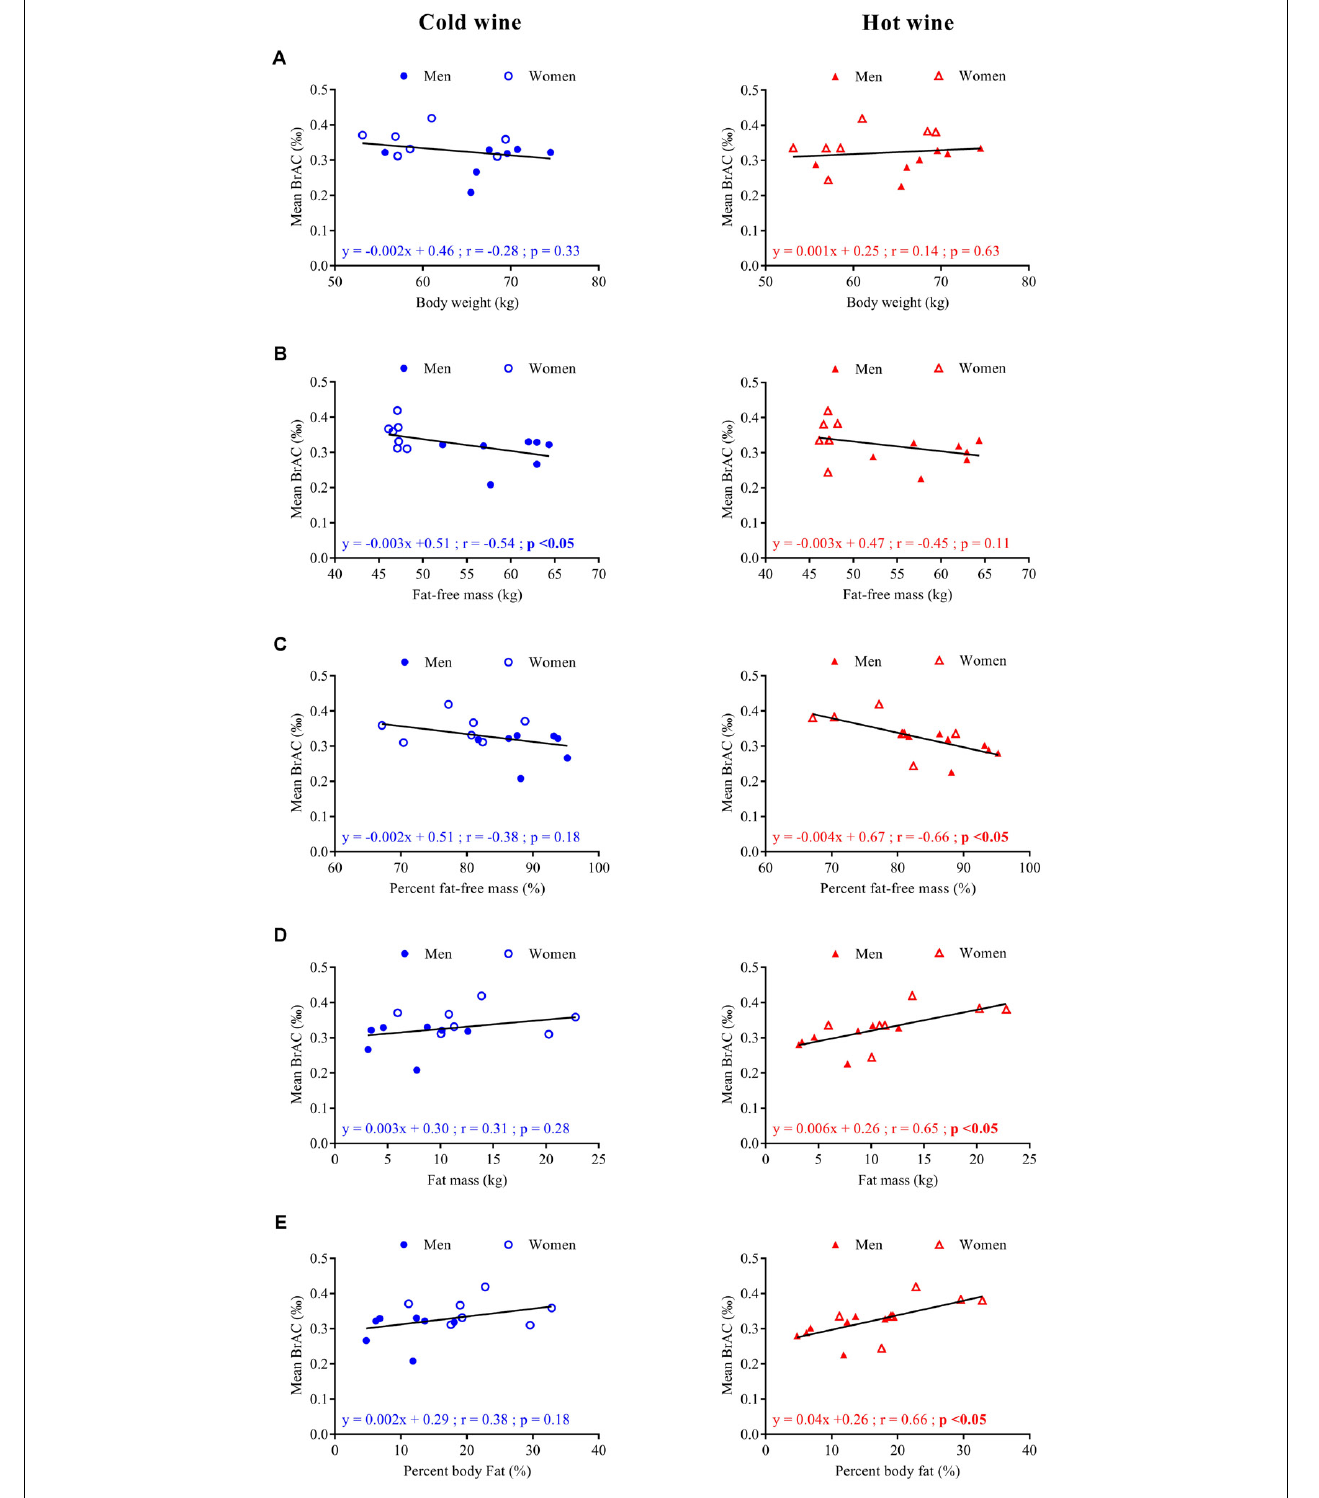
, (cid:78) ) and seven women ( , (cid:49) ) between mean BrAC [ 20 - 120 ] min after cold (left panels, blue symbols) and hot (right FIGURE 3 | Correlation analysis for seven men ( panels, red symbols) wine ingestion and body weight (A) , fat-free mass in kg (B) , percent fat-free mass (C) , fat mass in kg (D) , and percent body fat (E) . Regression (cid:32) (cid:35) lines (—), equations of the linear regressions, correlation coefficients ( r ), and p -values were obtained for 14 subjects.